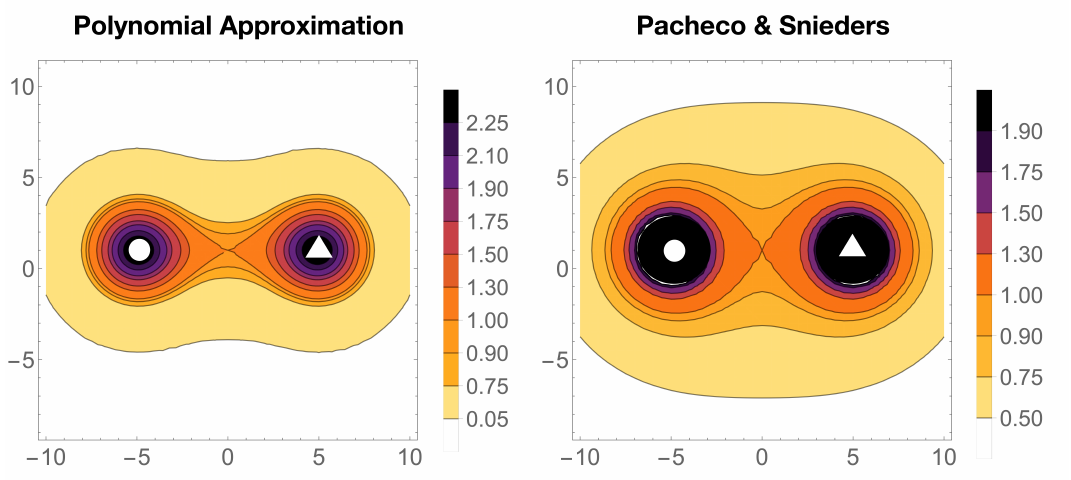
Figure 8. Contour plot of Equations (19) (Rightmost panel) and (16) with source (white circle) at { − 5.0,0.0} and receiver (white triangle) at {5.0,0.0}.